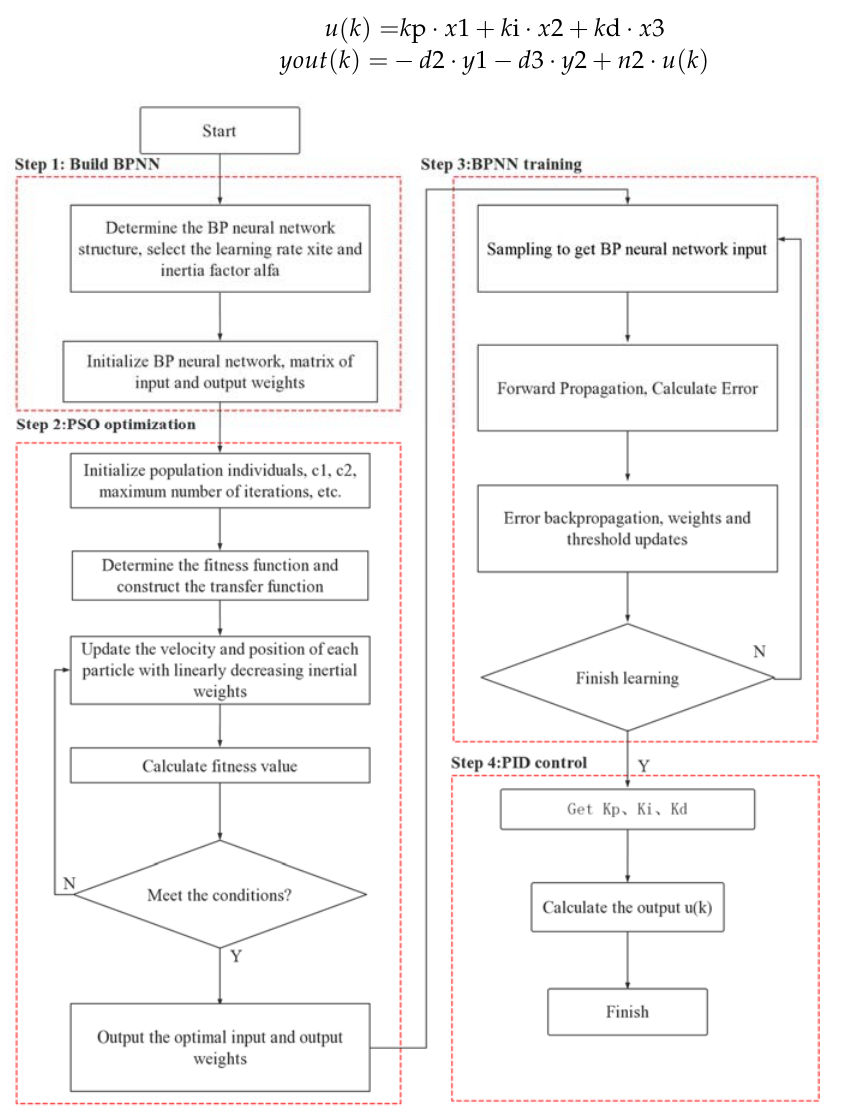
Figure 7. Flow chart of the PSO-BPNN-PID algorithm.